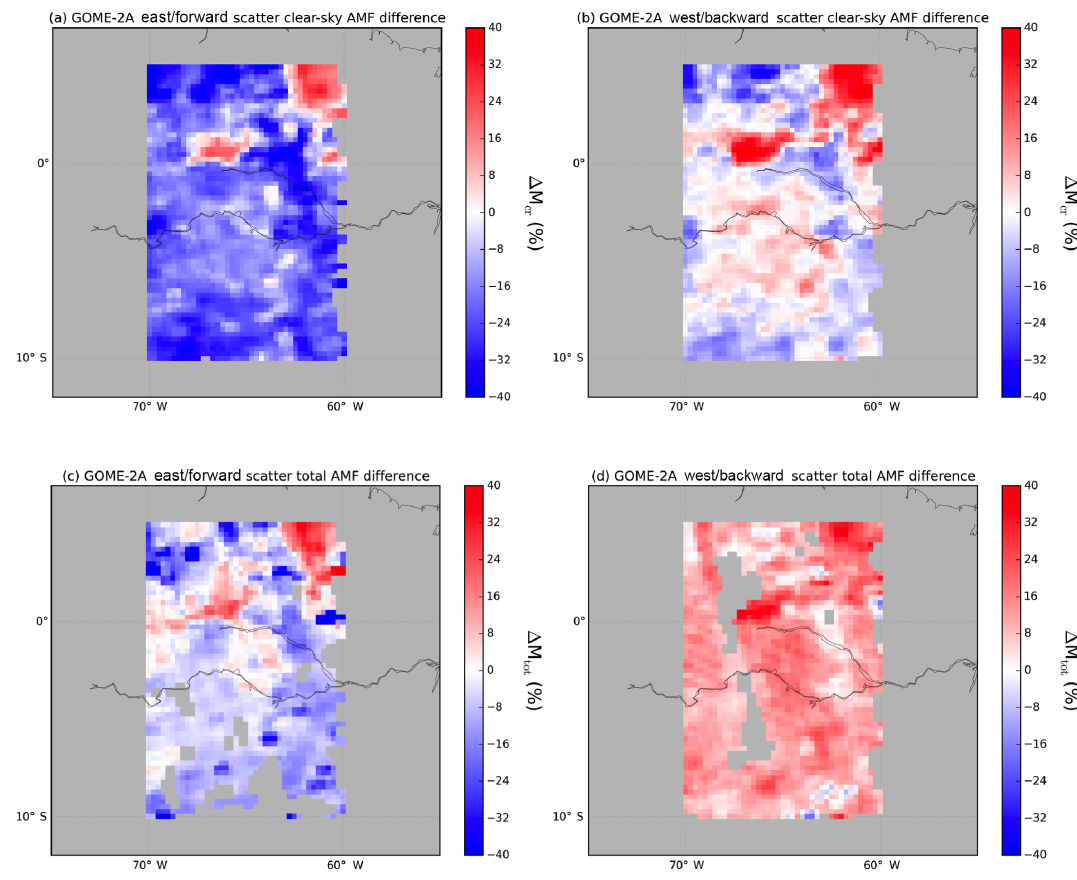
Figure 12. Relative differences between BRDF and Lambertian AMFs over Amazonia for March 2008: (a) clear-sky tropospheric NO 2 AMFs for east GOME-2A measurements (forward scatter), (b) clear-sky tropospheric NO 2 AMFs for west GOME-2A measurements (backward scatter), (c) total tropospheric NO 2 AMF for east GOME-2A measurements (forward scatter) and (d) total tropospheric NO 2 AMF for west GOME-2A measurements (backward scatter). Total AMFs are only shown for c eff < 0 .